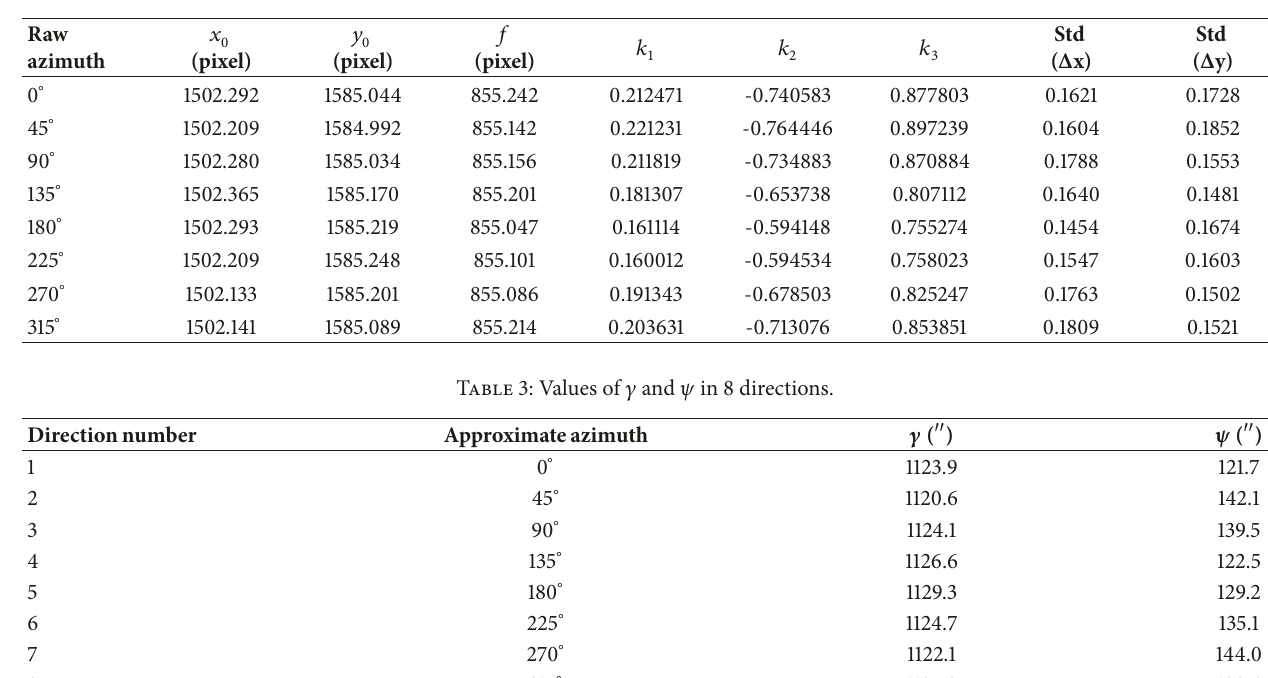
Table 2: Results of the 6 interior parameters in 8 directions.